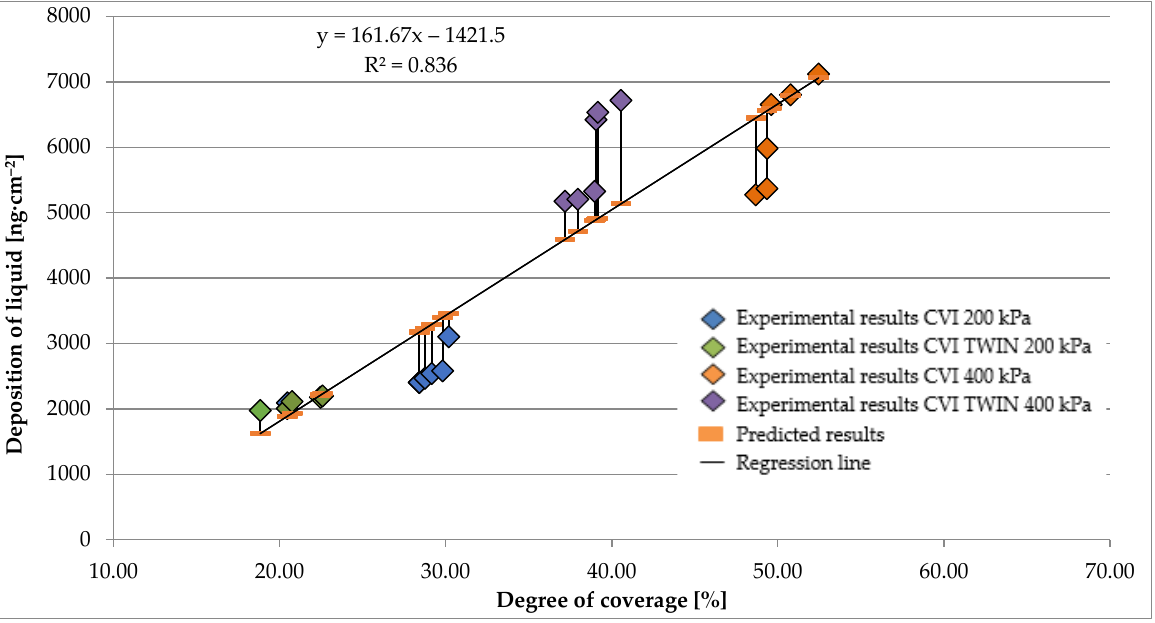
Figure 7. The scatter plot of the degree of coverage and deposition of spray liquid for selected air-induction nozzles for upper horizontal surface.